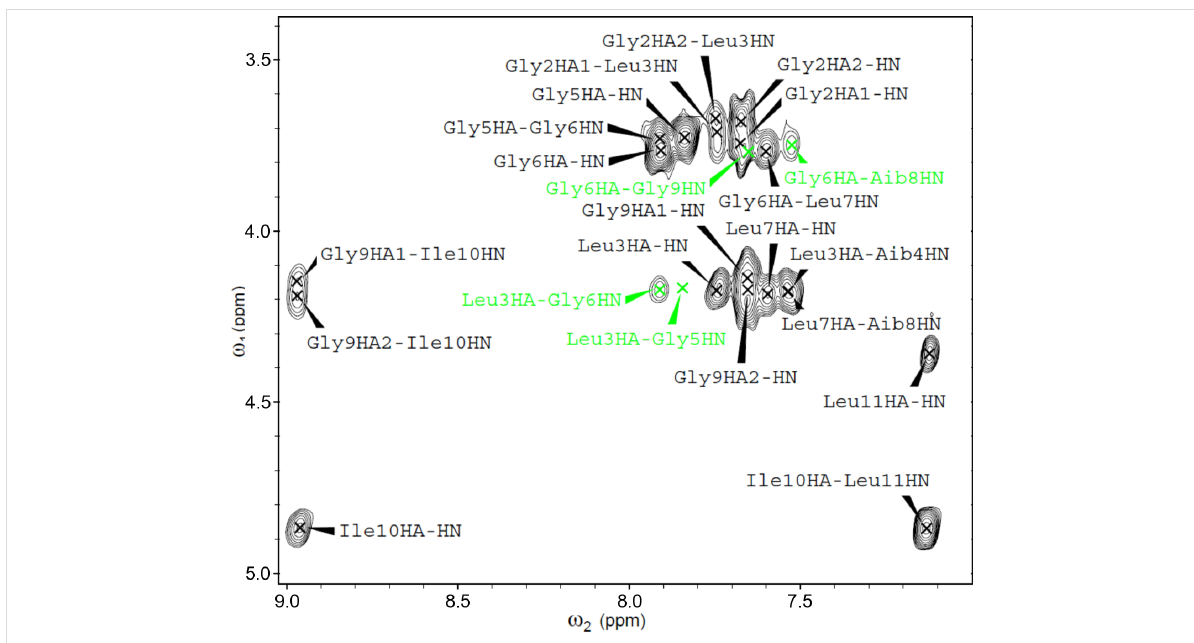
Figure 6: Fingerprint region of the H/H-ROESY spectrum of ψ [CS-NH] 9 (400 MHz, 1 mM in CD 3 CN solution, 298 K). The C α H i → NH i +2 , and C α H i → NH i +3 cross peaks are highlighted in color.